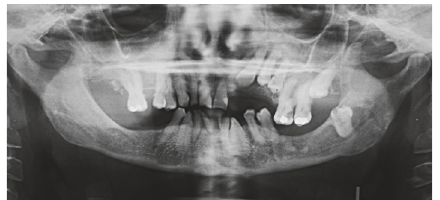
Figure 3: Orthopantomography revealed multiple dental anoma- lies: hypodontia, radicular fusion of 3.2–3.3, and impacted perma- nent teeth.